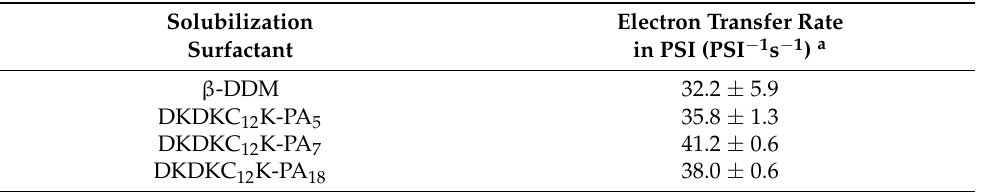
Table 3. Light-induced initial electron transfer rates in PSI solubilized with 0.1 wt% β -DDM in